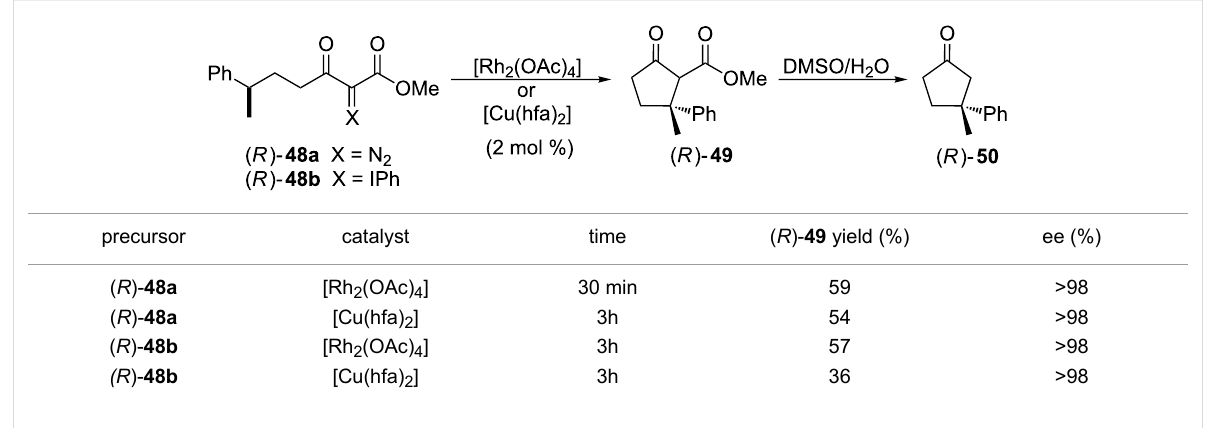
Table 4: Experimental evidences of the carbenoid formation from ( R )- 48a and ( R )- 48b and its intramolecular insertion into C(sp 3 )–H bonds.